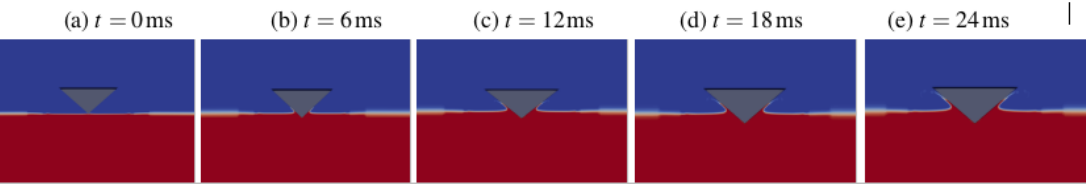
Figure 5. Displacement of the specimen center of mass. Comparison between CFD and experiments [79] for different h : ( a ) h = 0.25 m; ( b ) h = 0.50 m; ( c ) h = 0.75 m; ( d ) h = 1.00 m.